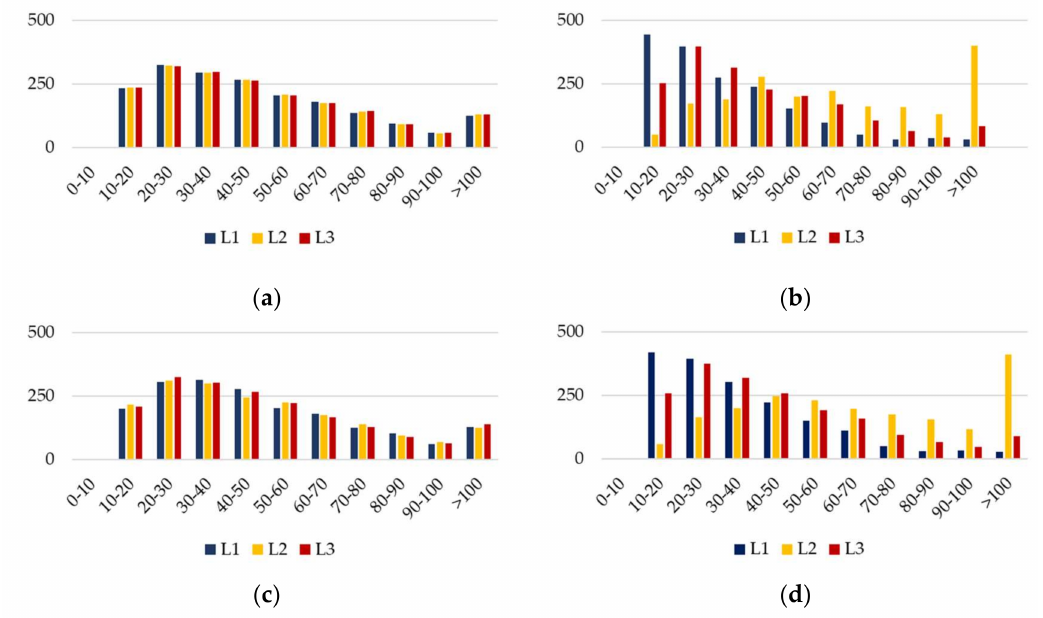
Figure 22. The number of hours during the year in which the reverse power flow is within the defined ranges (% of the rated current of transformer): ( a ) V3, ( b ) V5, ( c ) V8, and ( d )